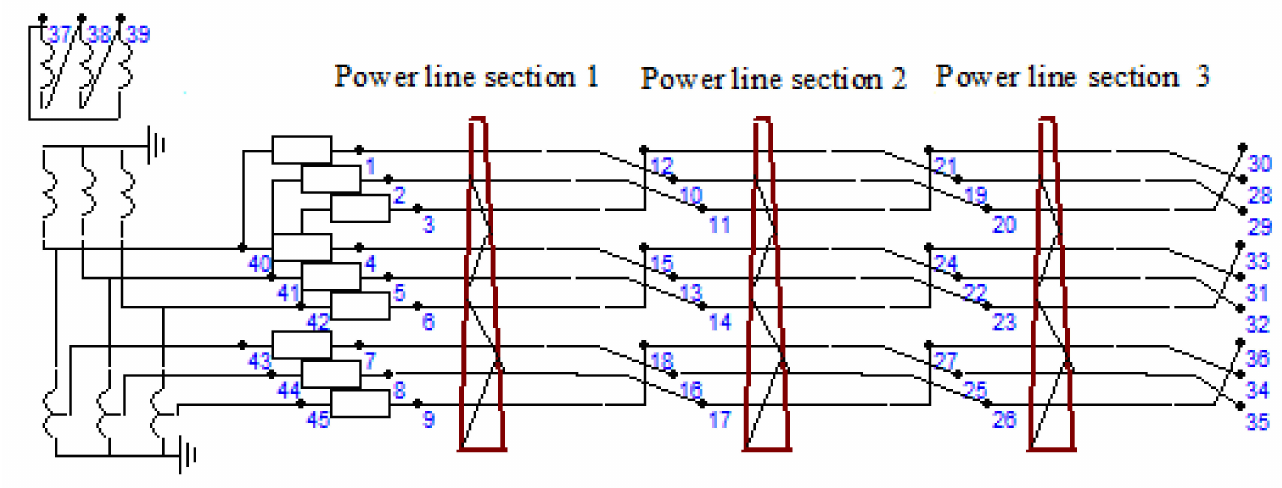
Figure 11. Equivalent circuit used by the Fazonord software package with a three-circuit line.